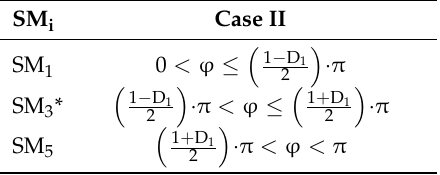
Table 7. Case II (v 11 ≥ v 22 and D 1 ≤ D 2 ): Boundaries for each extended switching